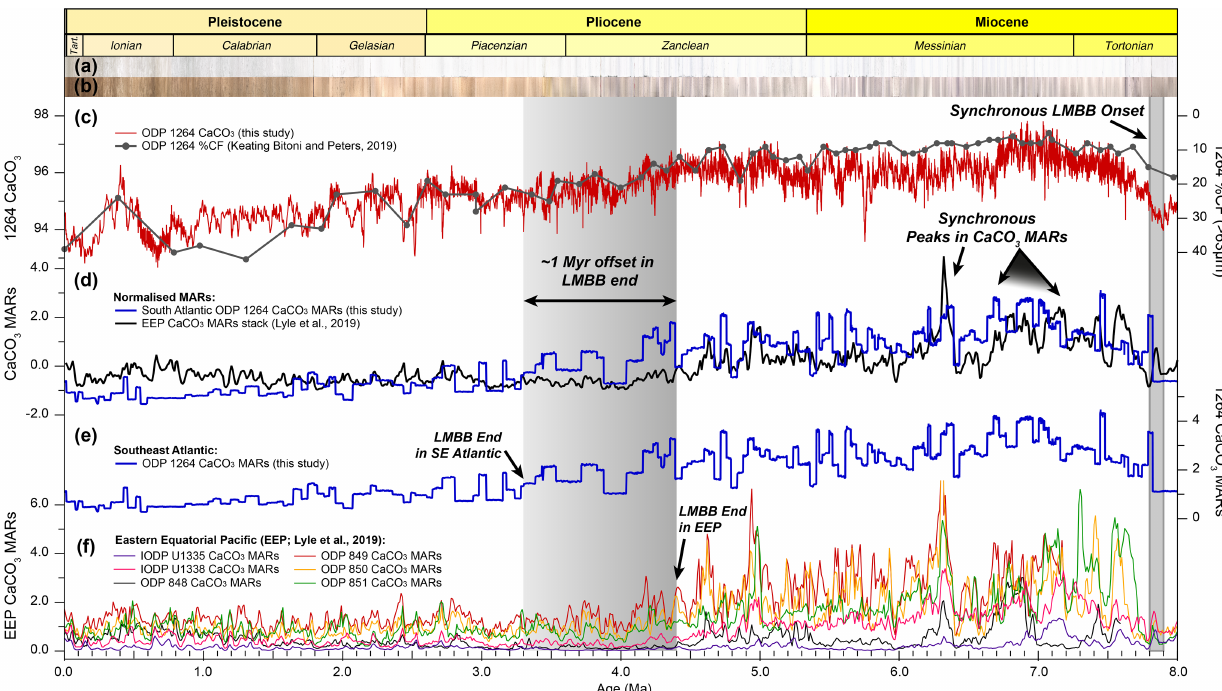
Figure 8. Late Miocene to present data on the new astrochronology. (a) The left axis shows XRF-derived CaCO 3 data from Site 1264 (dark red), and the right axis shows > 63µm coarse fraction (%CF) (Keating-Bitonti and Peters, 2019). (b) Normalised Site 1264 MARs (this study) and a normalised eastern equatorial Pacific (EEP) stack comprising data from ODP Sites 848, 849, 850, and 851 and IODP Sites U1335, U1337, and U1338 (Lyle et al., 2019). (c) Site 1264 CaCO 3 MARs. (d) MARS from EEP ODP Sites 848, 849, 850, and 851 and IODP Sites U1335 and U1338 (Lyle et al., 2019). Site U1337 is not shown here as it was partly affected by winnowing (see Lyle et al., 2019, for